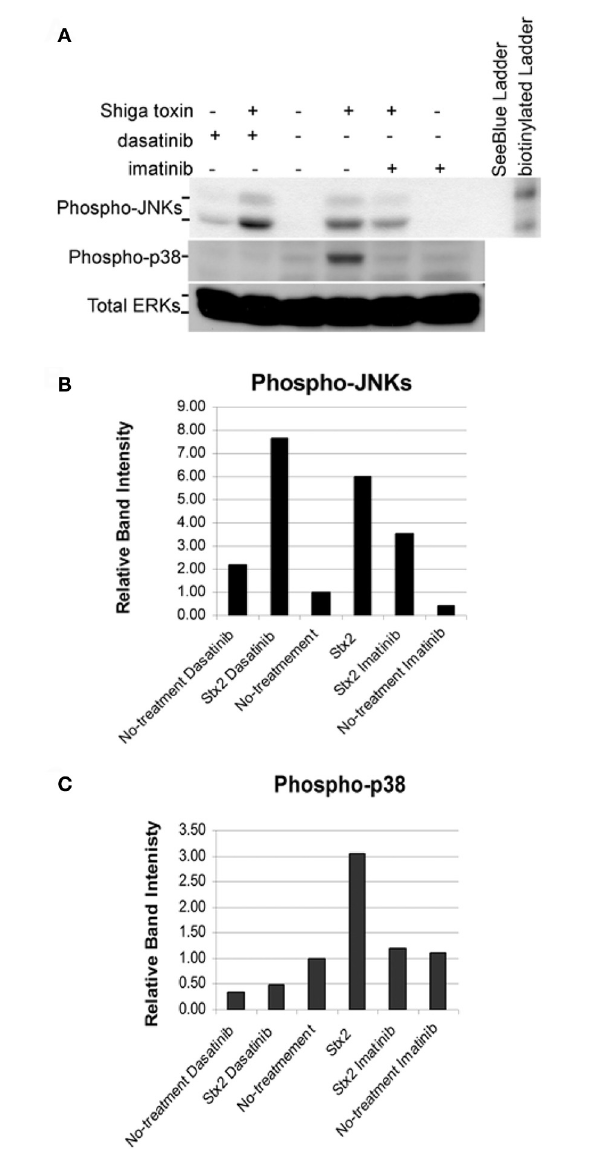
FIGURE 8 | Confluent HCT-8 cells were pretreated for 1h with DMSO (vehicle), 200 µ M imatinib, or 200 µ M dasatinib. Cells were then left untreated or treated with 5 μ g/ml of Stx2 for 4h. 150 μ g of protein from each whole cell lysate was loaded in each lane. (A) Western blots were performed for phospho-JNKs, phospho-p38,and total ERKs (loading controls). Graphical representation of normalized band intensities are shown for phospho-JNKs (B) and phospho-p38 (C)